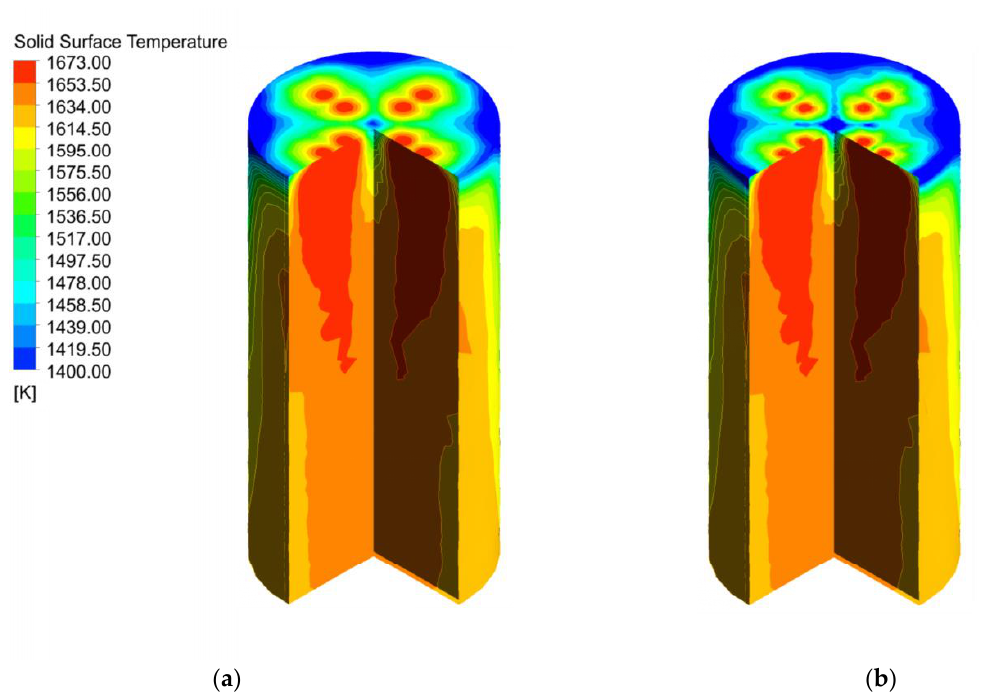
Figure 8. Solid temperature field at 40 mm and 80 mm ( a ) Solid surface temperature of 40 mm; ( b ) Solid surface temperature of 80 mm.